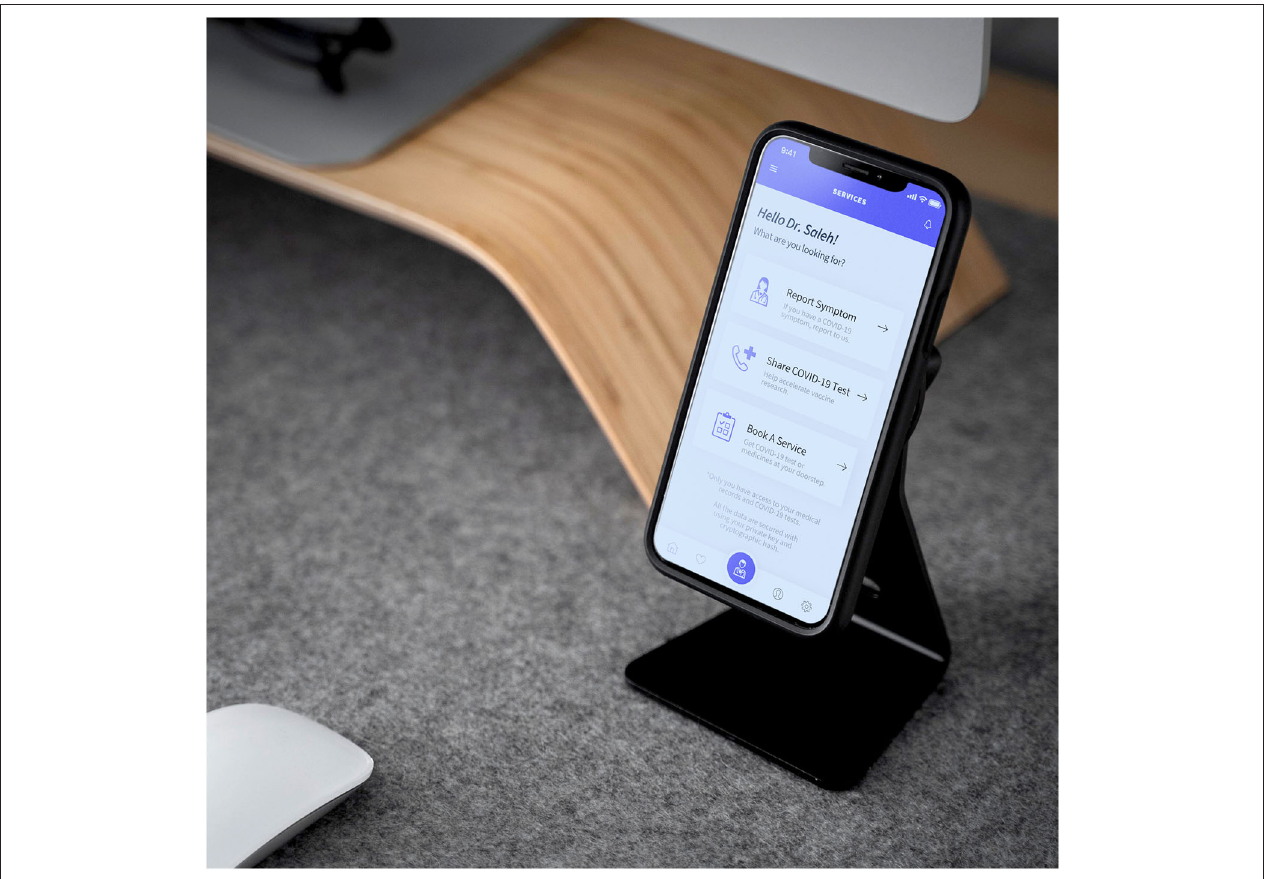
FIGURE 8 | The “Services”